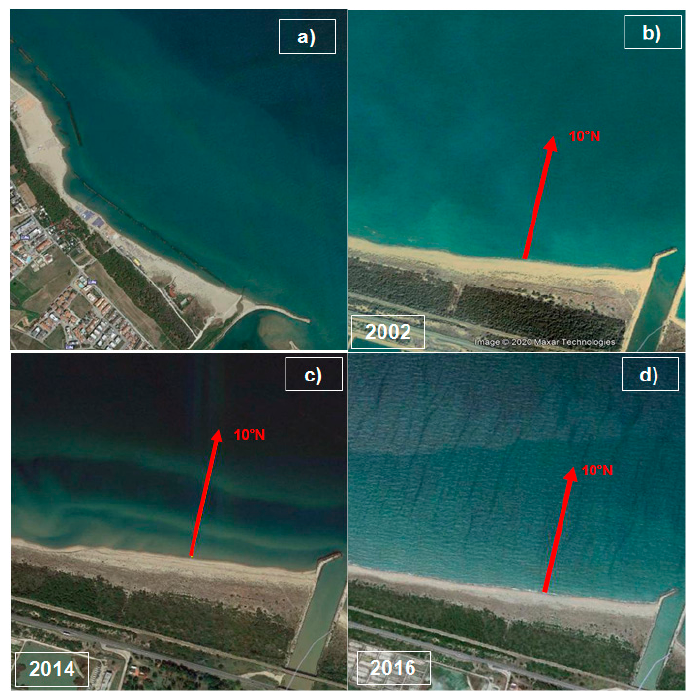
Figure 9. Panel ( a ) shoreline neighboring the area A4; panels ( b – d ), shoreline orientation at the Saccione stream jetty.